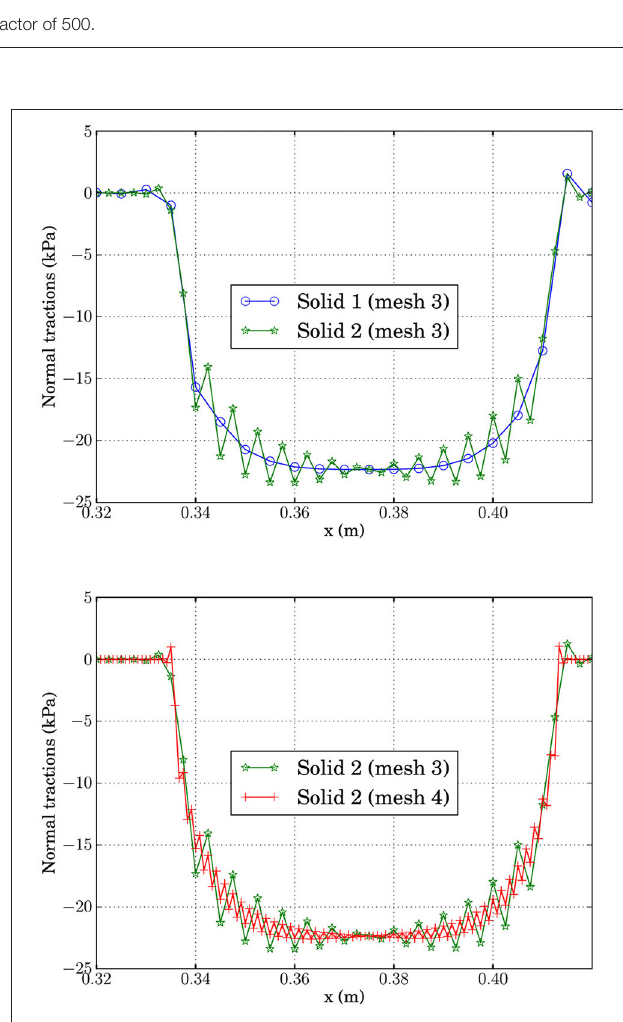
FIGURE 13 | Normal tractions computed along the potential contact zone by EC-BEM, for both domains and for two non-conforming Meshes 3 and 4 of Table 4 , with u D = 0.035